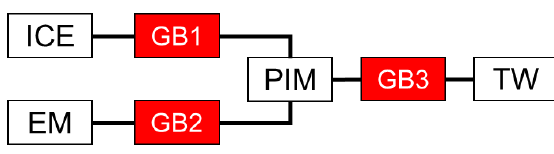
Figure 3. Gearbox location of parallel hybrid driveline.